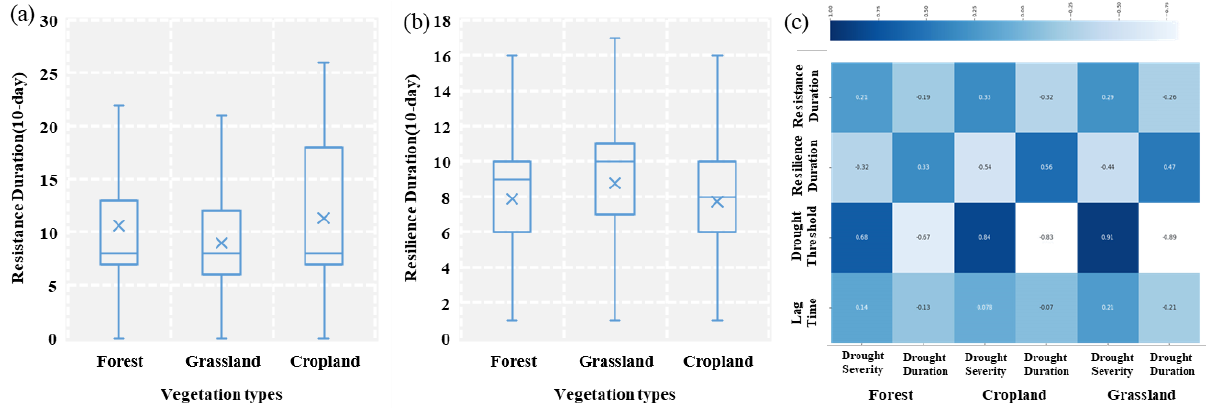
Figure 7. The drought impact on divergent vegetation types ( a ) the resistance duration in 2005/2006; ( b ) the resilience duration in 2005/2006; Box−and−whisker plots (25th to 75th percentiles at the ends of the box. Median is indicated with a horizontal line in the interior of the box. Maximum and minimum values are at the ends of the whiskers) ( c ) the Pearson correlation coefficient between drought characteristics and vegetation stability parameters; all of the above passed the significance test ( p < 0.01).